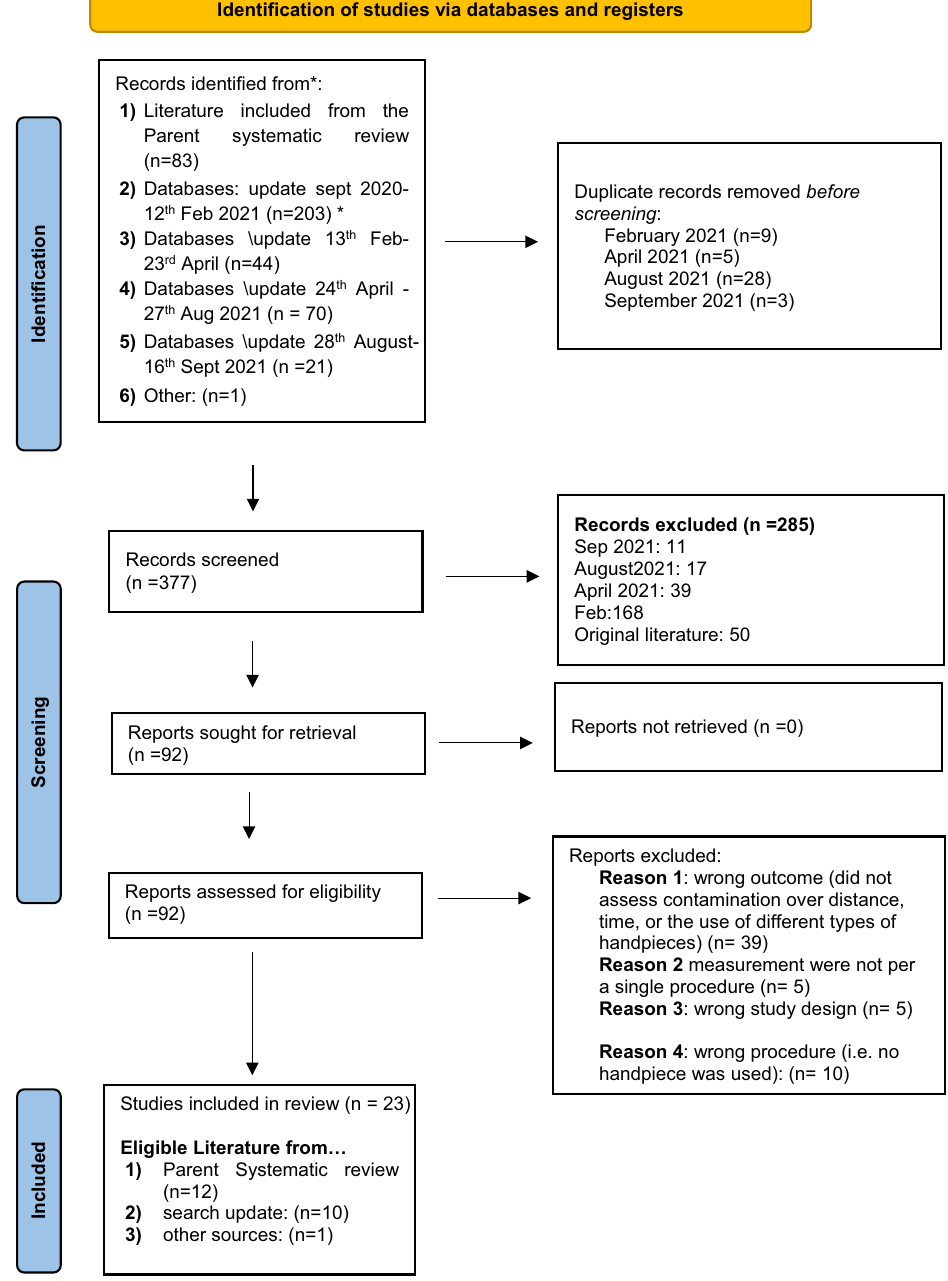
Fig. 1 PRISMA Flow diagram of the study [10]. PRISMA diagram, fl owchart demonstrating the results of searches and study